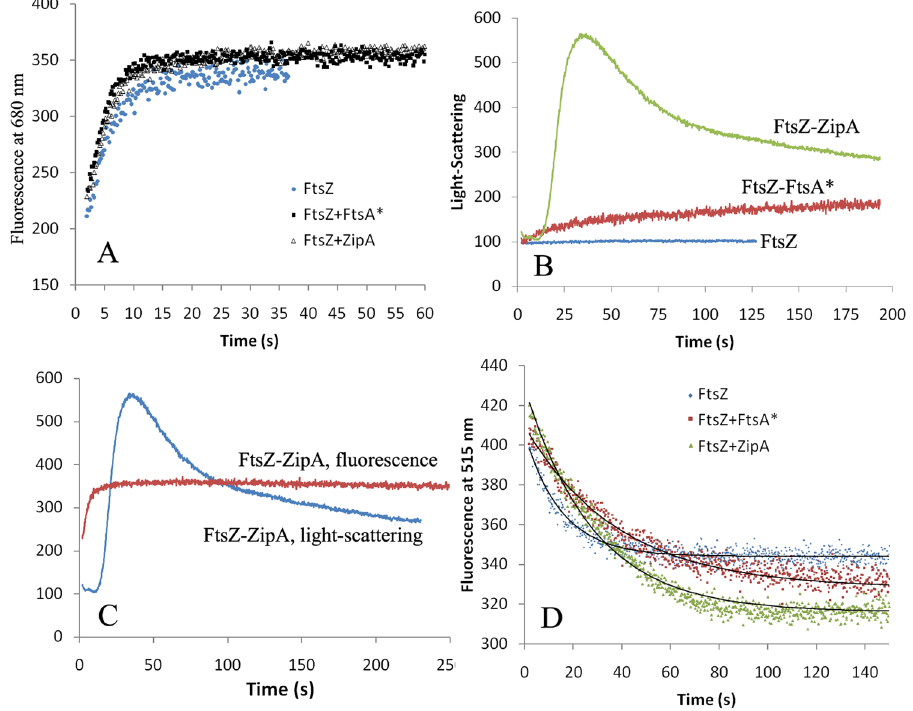
Figure 6. Dynamics of the FtsZ assembly and filament turn-over in MMK buffer, pH 6.5. ( A ) FtsZ assembly kinetics measured by Atto fluorescence. Assembly is almost the same for FtsZ alone and with ZipA and FtsA * . ( B ) FtsZ assembly kinetics measured by light-scattering. The enhanced light scattering with ZipA and FtsA * reflects bundling. ( C ) Direct comparison of the assembly kinetics of FtsZ-ZipA mixture measured by Atto fluorescence and light-scattering. Filament assembly reported by ATTO fluorescence precedes the bundling reported by light scattering. ( D ) The kinetics of FtsZ filament turn-over measured by FRET technique. The turn- over rates are slower for polymers with ZipA or FtsA *